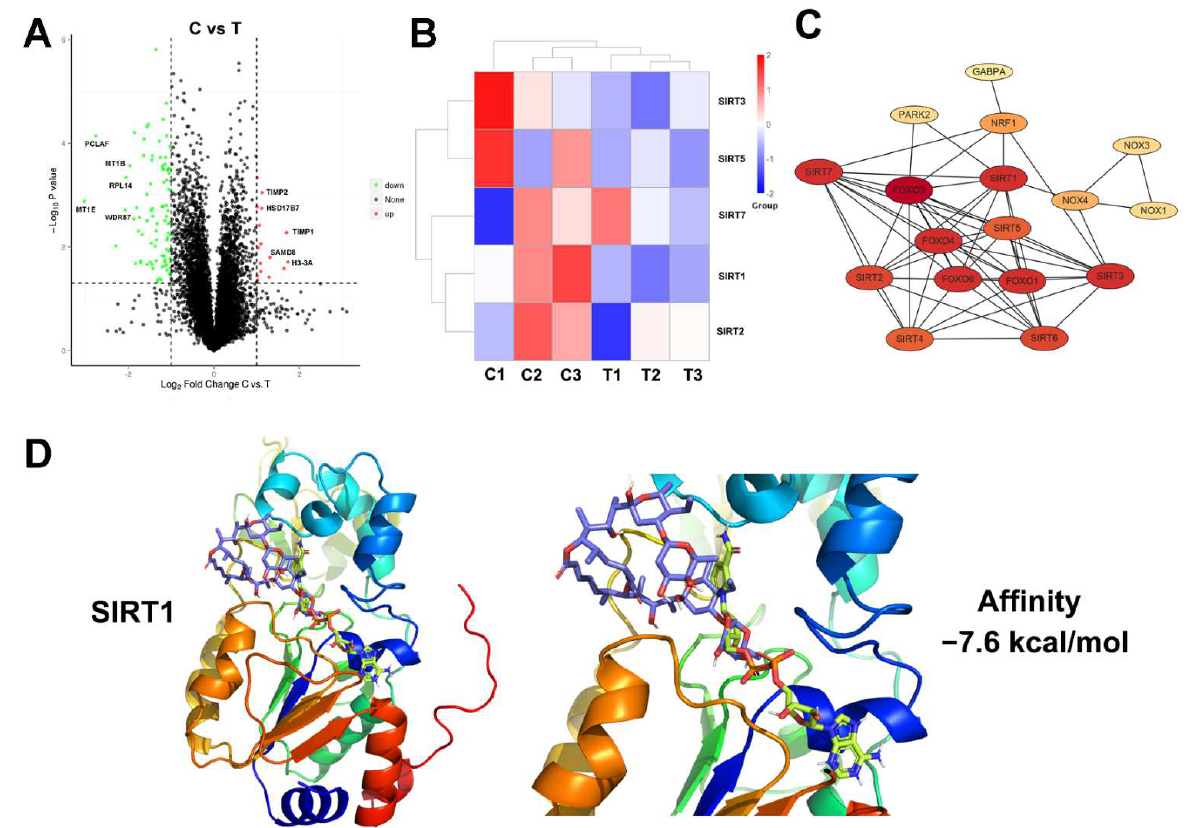
Figure 4. Proteomic analysis and molecular docking for target prediction of elaiophylin in A549 cells. ( A ) Volcano plots of differentially expressed proteins. ( B ) Heatmap analysis of SIRTs between elaiophylin treated group (0.25 µM) and control group. C: controls, T: treatment. ( C ) PPI network for the SIRTs. ( D ) Computational docking of elaiophylin and SIRT1 protein. NAD + : yellow sticks; elaiophylin: purple sticks.